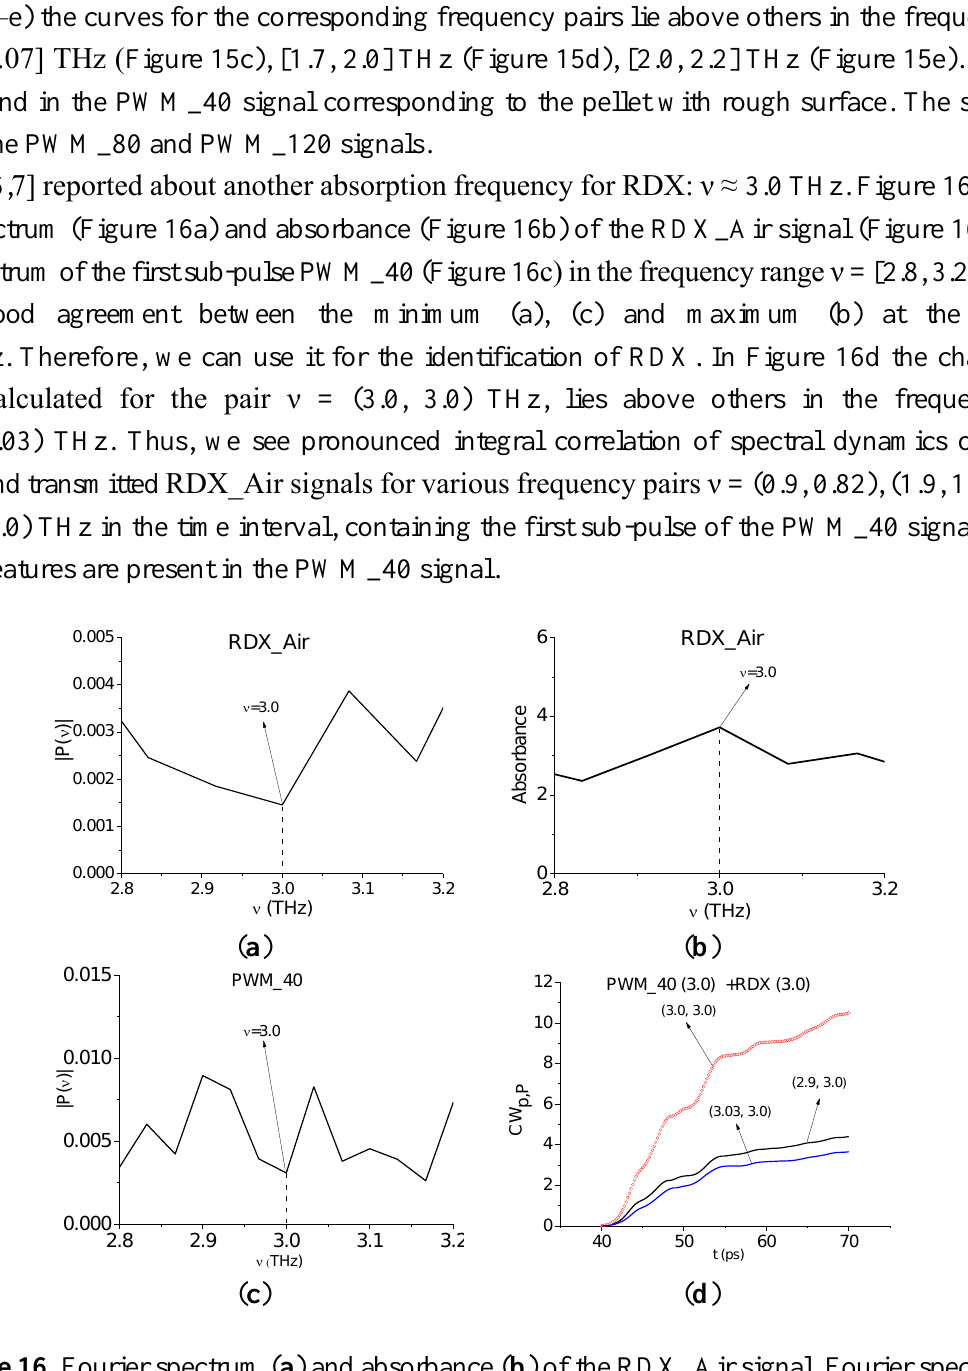
Figure 16. Fourier spectrum ( a ) and absorbance ( b ) of the RDX_Air signal, Fourier spectrum ( c ) of the first sub-pulse of the PWM_40 signal in the frequency range ν = [2.8,3.2] THz; integral characteristic CW p , P ( t n ) detecting the frequency ν = 3.0 THz ( d